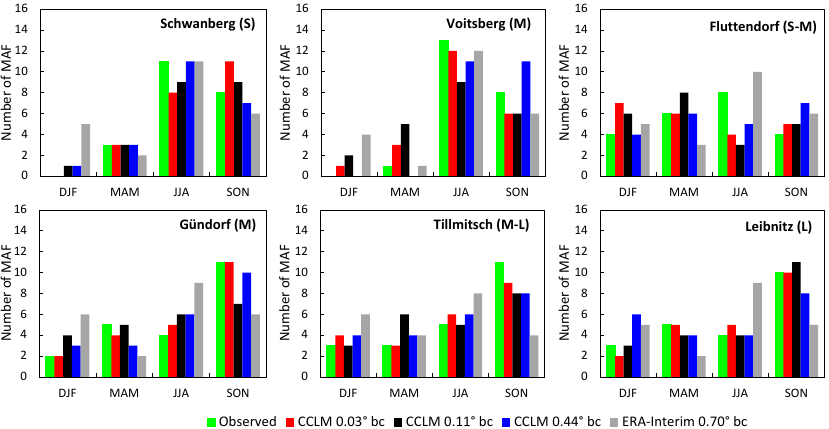
Figure 14. Number of maximum annual floods in the four seasons (seasonality) from the simulation using bias-corrected CCLM data as input compared to the observation at the selected gauges in the period